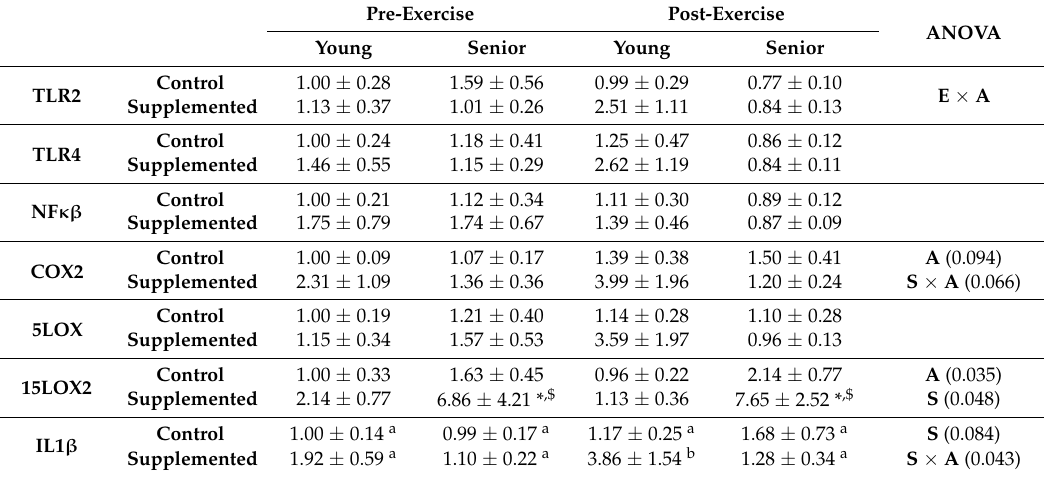
Table 6. Effects of dietary functional beverage supplementation, exercise and age on the expression of inflammatory and related